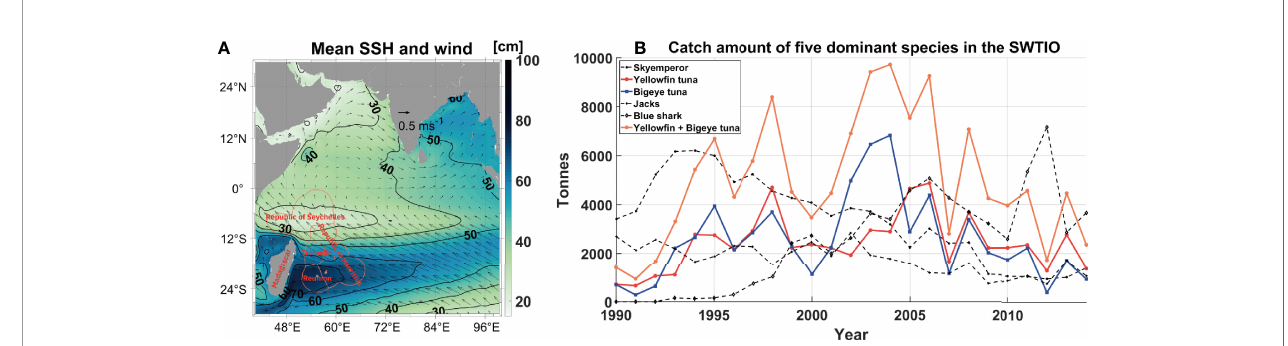
FIGURE 1 | (A) Mean sea surface height (SSH) (color shading and contours) and wind velocity (vectors) in the tropical Indian Ocean for 1990 – 2014. Red contour lines illustrate the boundaries of the four exclusive economic zones (the Republic of Seychelles, the Republic of Mauritius, Tromelin Island, and Reunion Island) in the southwestern tropical Indian Ocean (SWTIO). (B) The annual catch amounts of the fi ve dominant species (skyemperor, yellow fi n tuna, bigeye tuna, jacks, and blue shark) in the SWTIO during 1990 – 2014. The red and blue lines denote the catch amounts of yellow fi n tuna and bigeye tuna, respectively, and the orange line denotes the catch amount of Thunnus genus (yellow fi n tuna + bigeye